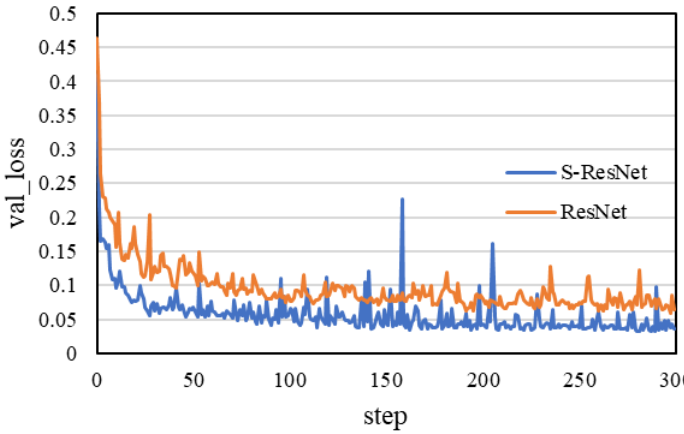
Figure 16. The change of the loss of the two IDSs when testing models.